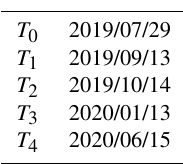
Figure 15. Orthophoto with M3C2 distance. The distance scale has been adjusted to exclude values between − 2 and + 2cm. The pos- itive distances, observed at the margin of the mud dome, are inter- preted as mud flow or sediment deposition coming from peripheral griffon vent eruptions or erosion of summit area. The reference sys- tem is WGS 84/UTM zone 33N. Table 2. Surveys used to generate the time series. Dates are given in